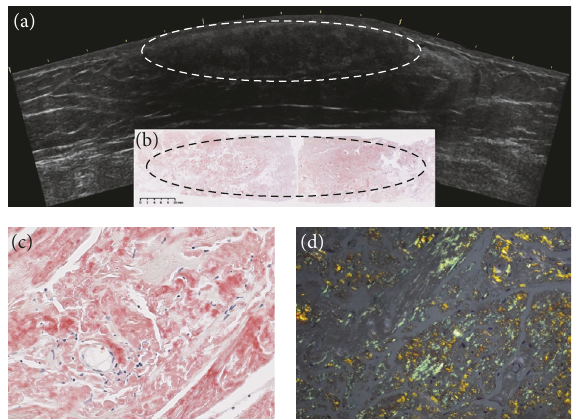
Figure 3: Comparison of preoperative abdominal ultrasound find- ings (a) and Congo red-stained histopathological findings (b). The high magnification figures ( × 200) of Congo red staining (c) and its green birefringence (d). (a) On ultrasonography, the subcutaneous mass is shown as a somewhat heterogeneous, hypoechoic area under the dermis. (b) Congo red-stained section of the mass shows diffuse, irregular, lumpy amyloid deposition (indicated by broken-lined ovals). When the material was stained with Congo red staining (c) and seen with polarized light, we saw green birefringence (d), diagnostic of